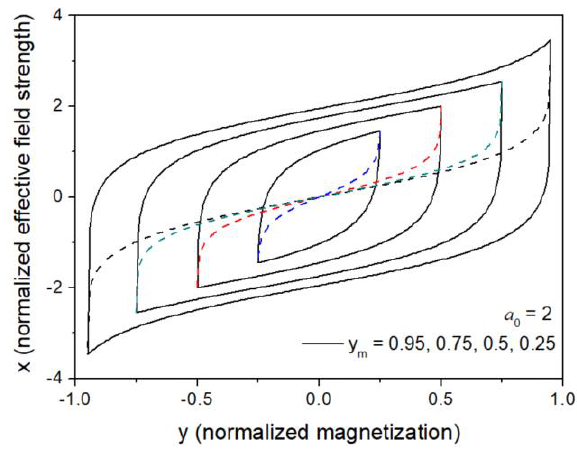
Figure 6. A family of simulated symmetric hysteresis loops and the corresponding anhysteretic curves for 𝑎 0 = 2.